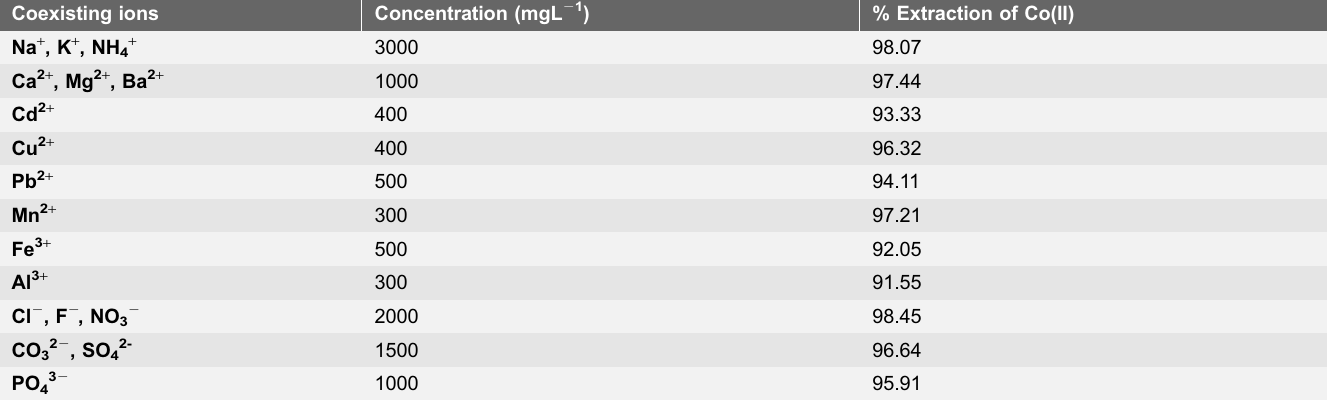
Table 3. Effect of matrix interferences on the extraction of 1.0 mgL 2 1 Co(II) on 25.0 mg Ag 2 O 3 -ZnO NCs ( N 5 3). Coexisting